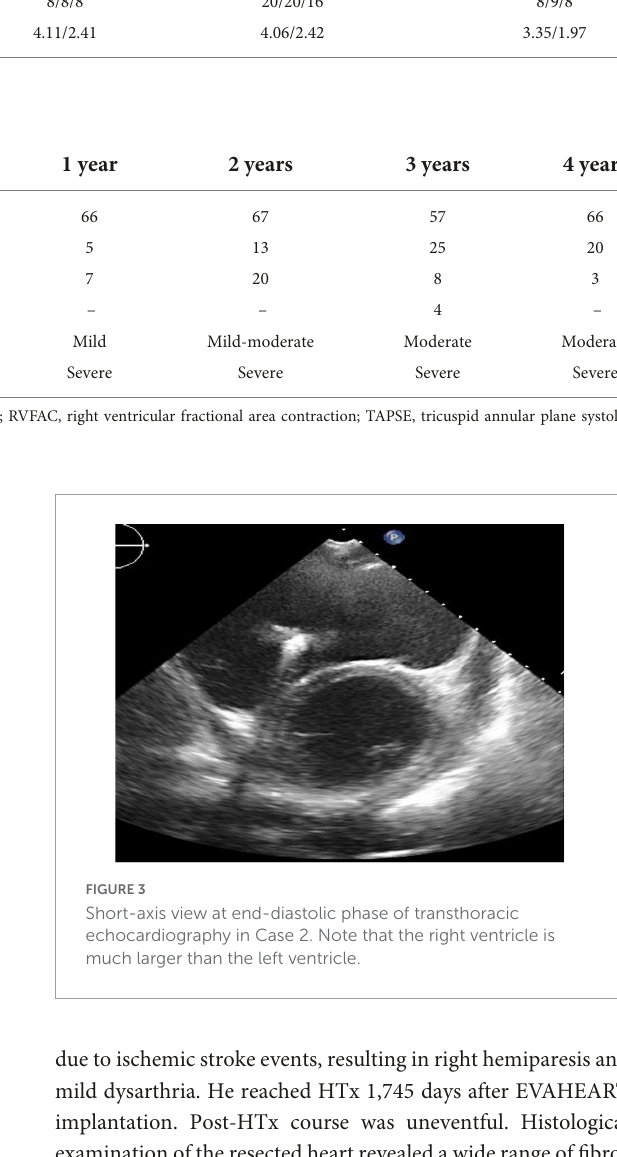
due to ischemic stroke events, resulting in right hemiparesis and mild dysarthria. He reached HTx 1,745 days after EVAHEART implantation. Post-HTx course was uneventful. Histological examination of the resected heart revealed a wide range of fibro- fatty replacements mainly in the RV. The final pathological diagnosis was